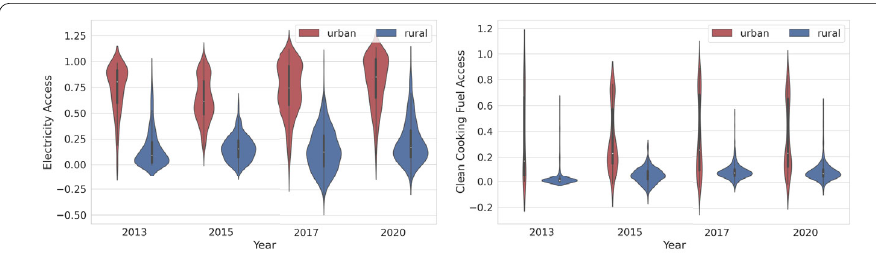
Figure 3 Disparity in energy access disaggregated along the urban-rural divide. Each violin plot shows the distribution of energy access for microregions for 2013, 2015, 2017 and 2020. Red denotes urban and blue denotes rural